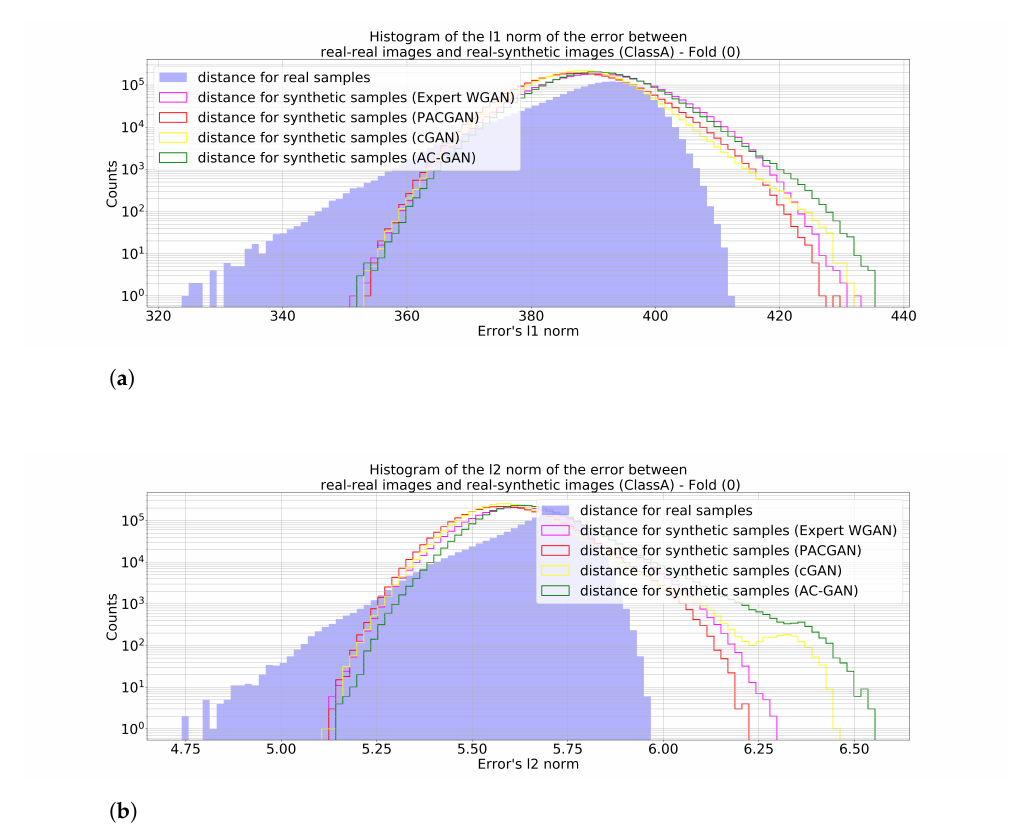
Figure 14. The (cid:96) 1 ( a ) and (cid:96) 2 ( b ) errors between real-real images and real-synthetic images considering the different GAN models. Real images were taken from the training set for Fold 0 from the LORO- based